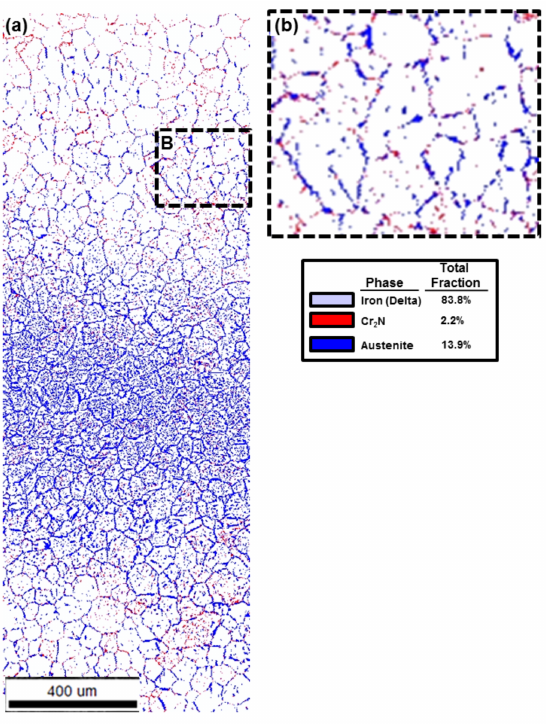
Figure 10. EBSD results at the edge of the medium heat input weld: ( a ) phase map; and ( b ) magnification at location ‘B’ of ( a ).